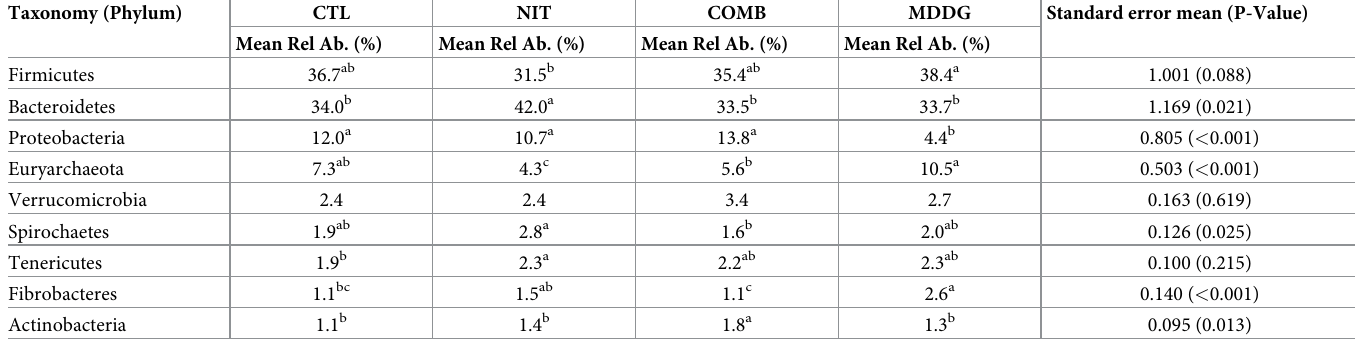
Different letters within column are significantly different at P < 0.05.